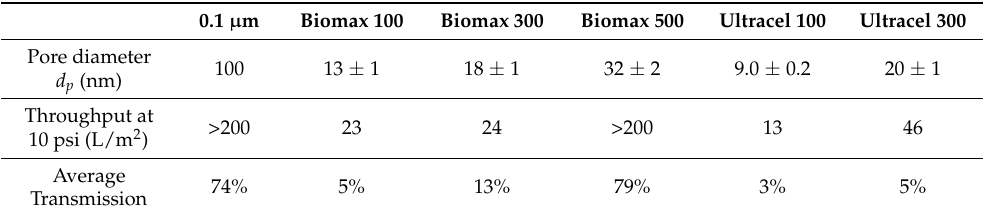
Table 2. Pore size, throughput (evaluated at TMP = 10 psi), and average transmission for 0.1 µ m mixed cellulose ester, Ultracel, and Biomax